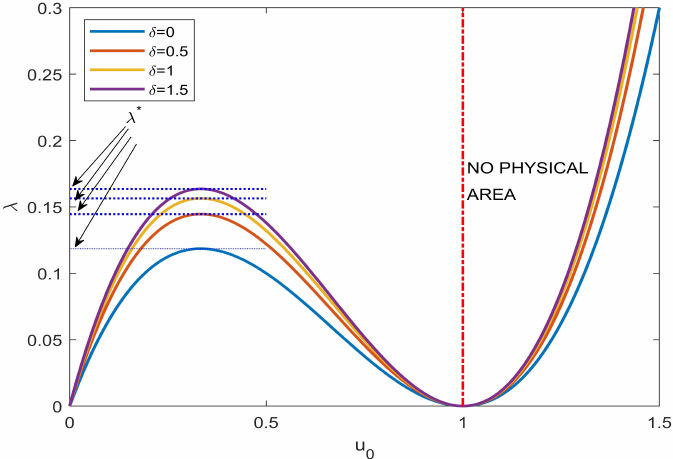
Figure 9. Dimensionless λ ∗ as a function of a dimensionless u